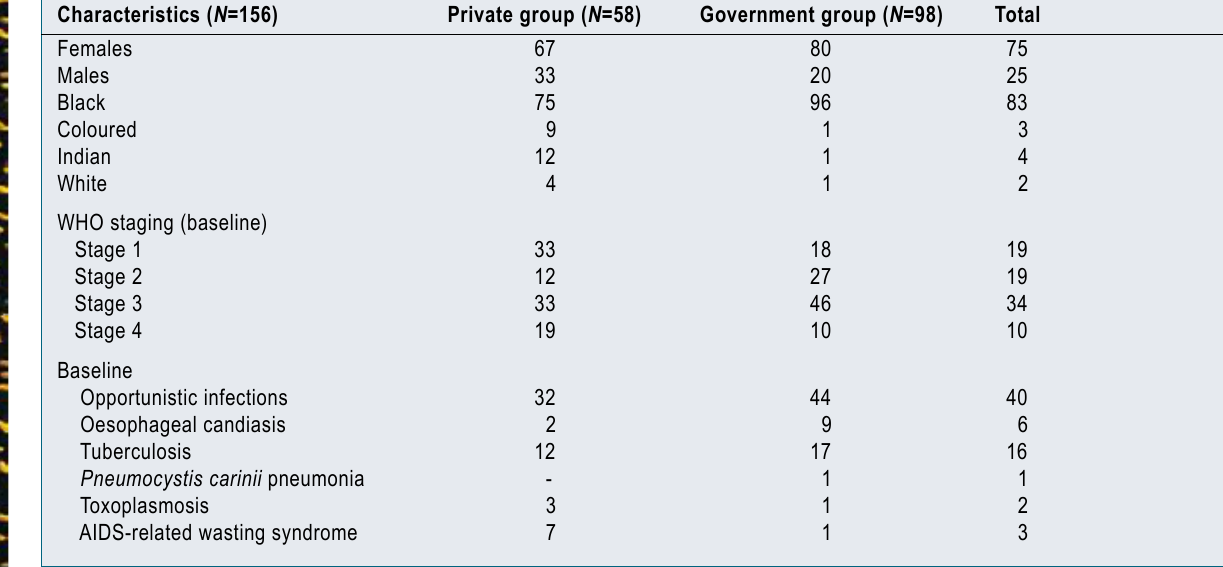
TABLE I. PATIENT BASELINE CHARACTERISTICS